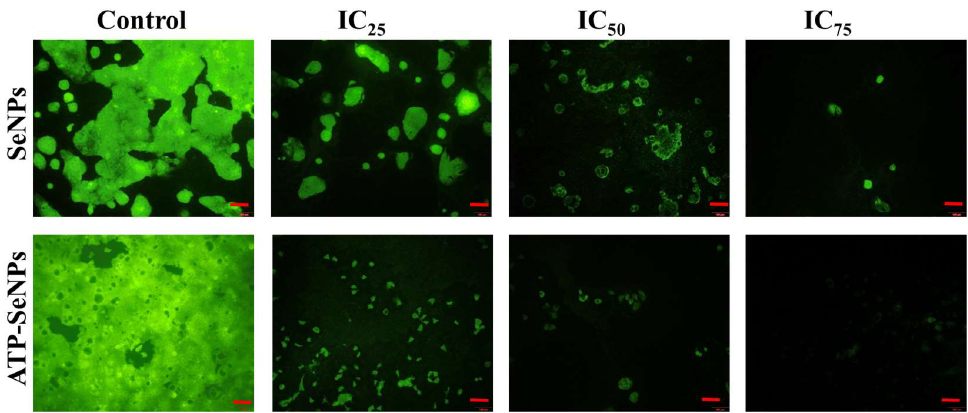
Figure 7. Analysis of SeNPs and ATP-SeNPs-induced mitochondrial membrane potential loss in human colon cancer cell line by rhodamine 123 (Rh123) staining assay. Scale bar (100 µm).